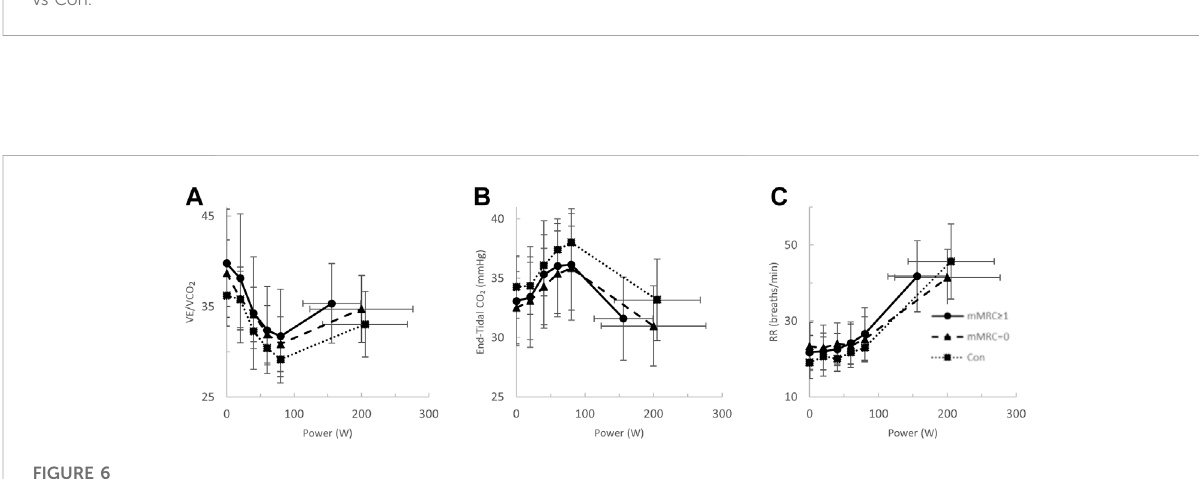
FIGURE 5 The (A) oxygen uptake (VO 2 )- and (B) ventilation (VE)-power relationships and the diffusing capacity for carbon monoxide (DLCO)-VO 2 relationships in mMRC > 1 (dyspneic-CoV, circles, solid line), mMRC = 0 (triangles, dashed line) and Con (squares, dotted line). † = p < 0.05 mMRC ≥ 1 vs